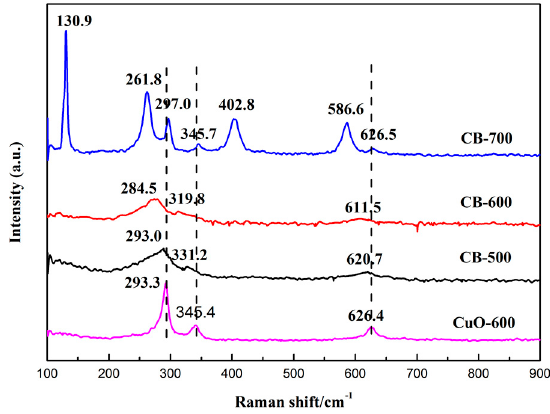
Figure 2. Raman spectra of the CuO-Bi 2 O 3 catalysts in this study.